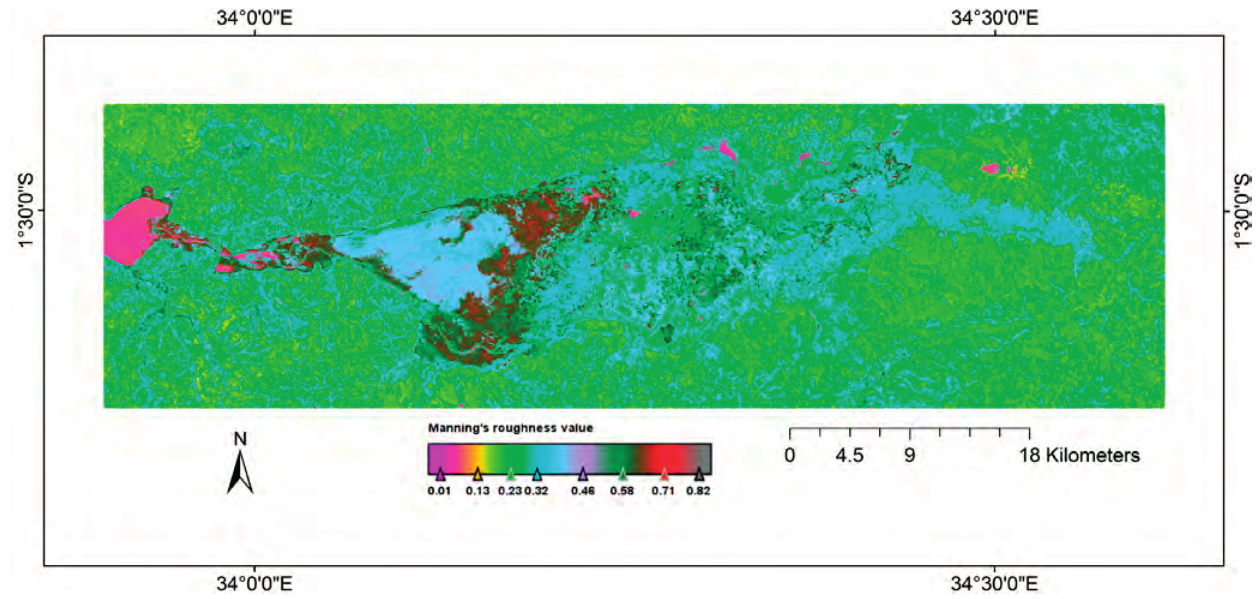
Figure 12. Spatial Manning’s roughness coefficient (m − 1/3 /s) derived from Landsat TM based vegetation map and relative surface roughness from SAR imagery.